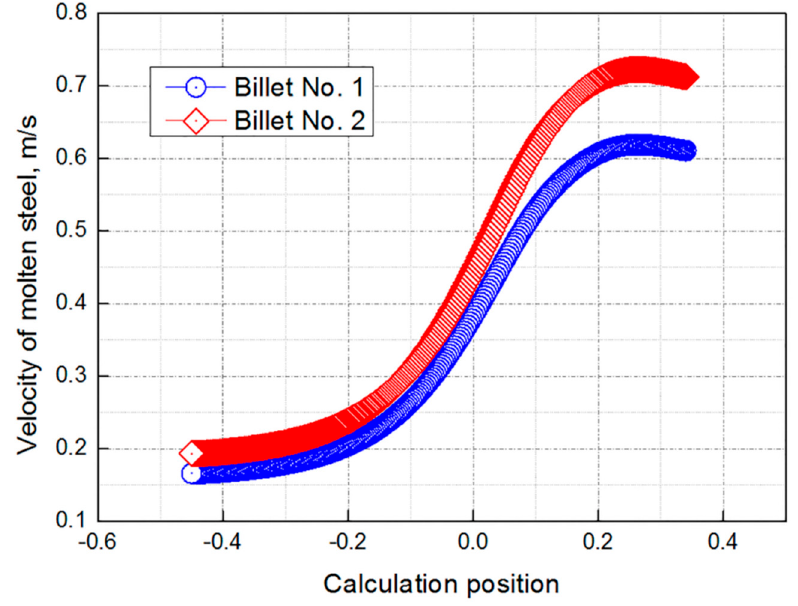
Figure 13. Velocity distribution along the centerline from the submerged entry nozzle to the end of the mold. Table 7. Velocity discrepancy and gradient of molten steel when the velocity decreases to 0.193 m/s.